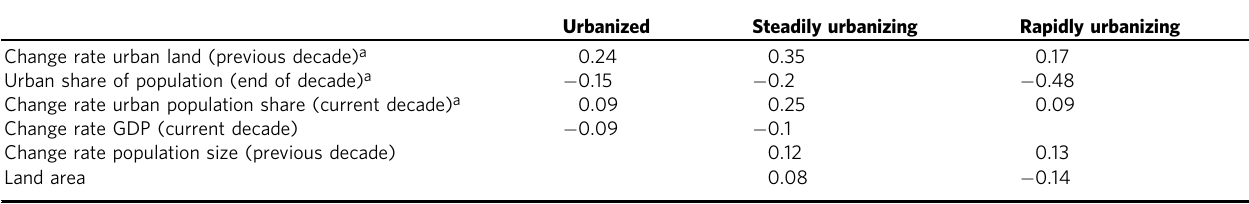
Table 1 Drivers of urban land expansion and their effects on different styles of urbanization, shown by standardized coef fi cients of linear models trained for the three